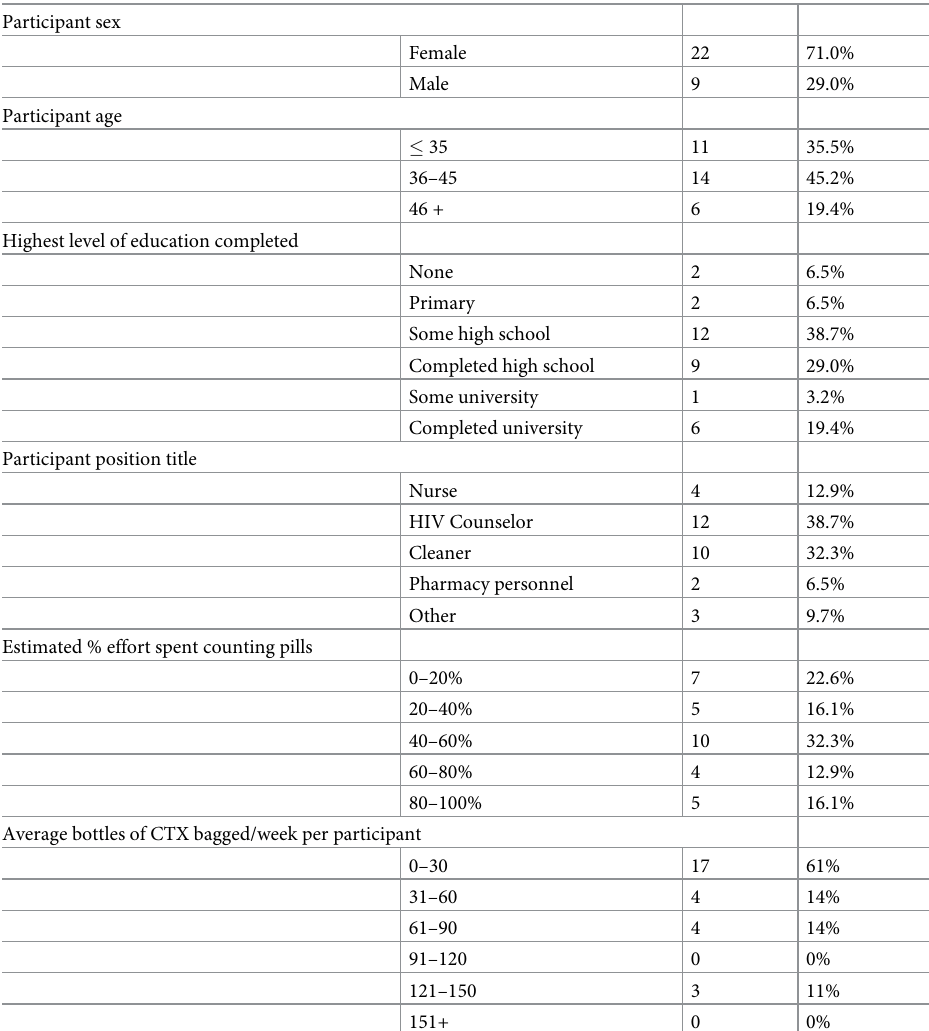
Table 2. Participant